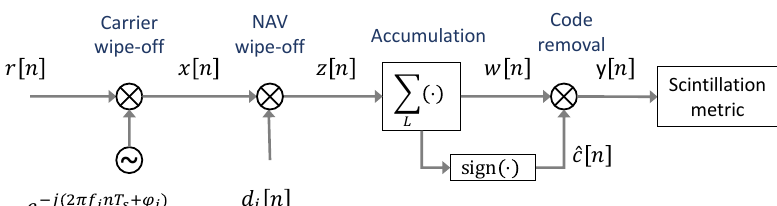
Figure 4. Block diagram of the assisted open loop architecture used to perform the